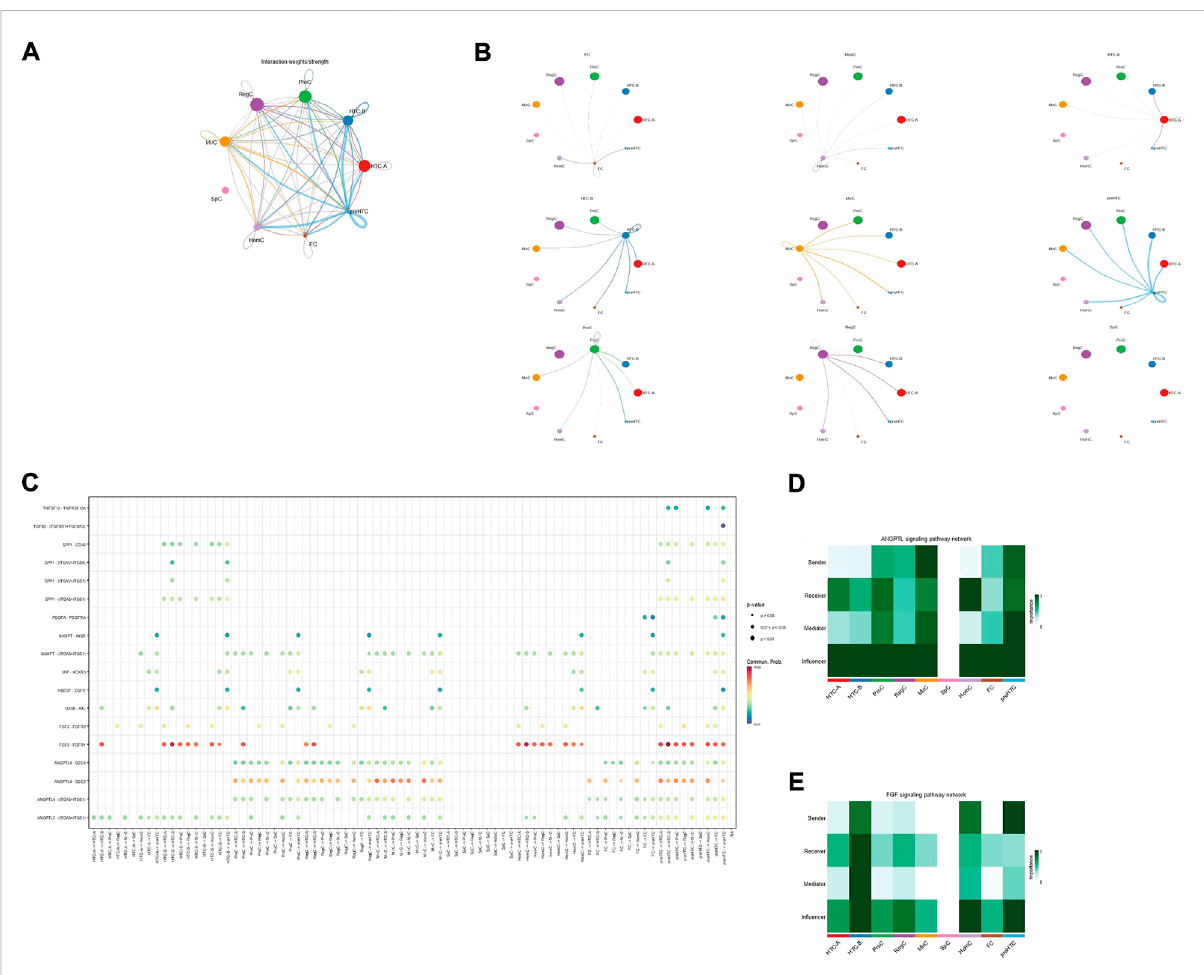
FIGURE 3 Results for the cell – cell interaction among cell types. (A,B) Interaction weight for cell – cell communication among each cell type. The size of the circle represents the ratio of each cell type; the width of the line represents the strength of cell – cell communication. (C) Interaction probability for each pathway among cell types; the size and color of the circle represent the p -value and probability, respectively. (D,E) Heatmap for the role of each cell type in different pathways; the color of the rectangle represents the extent of importance in each